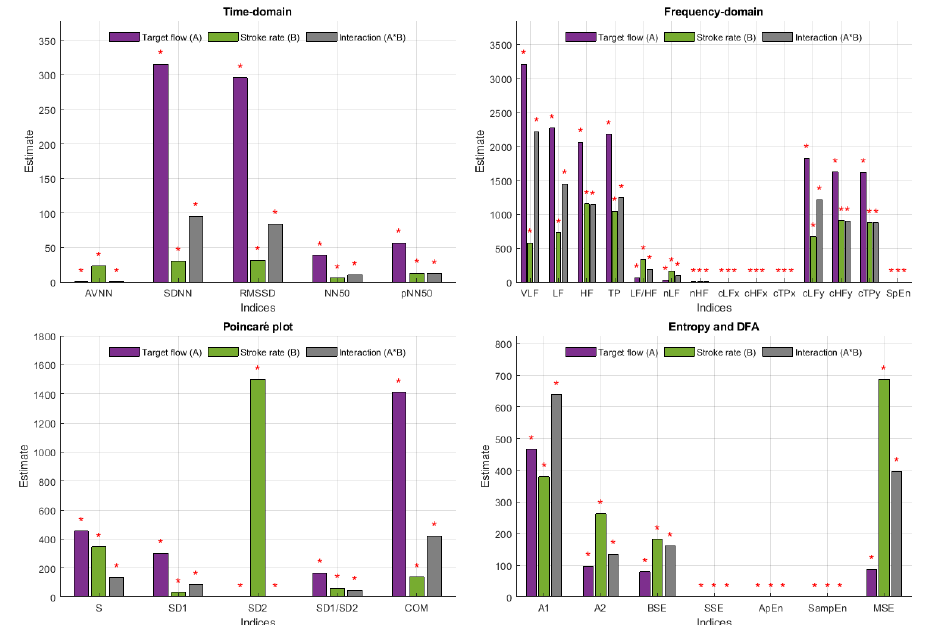
Figure 7. Effect estimates for stroke rate (SR), target flow (TF) and their interaction on each of the indices extracted from pulse rate variability (PRV) measured from the radial phantom. Red stars on top of the bars indicate statistically significant effects.